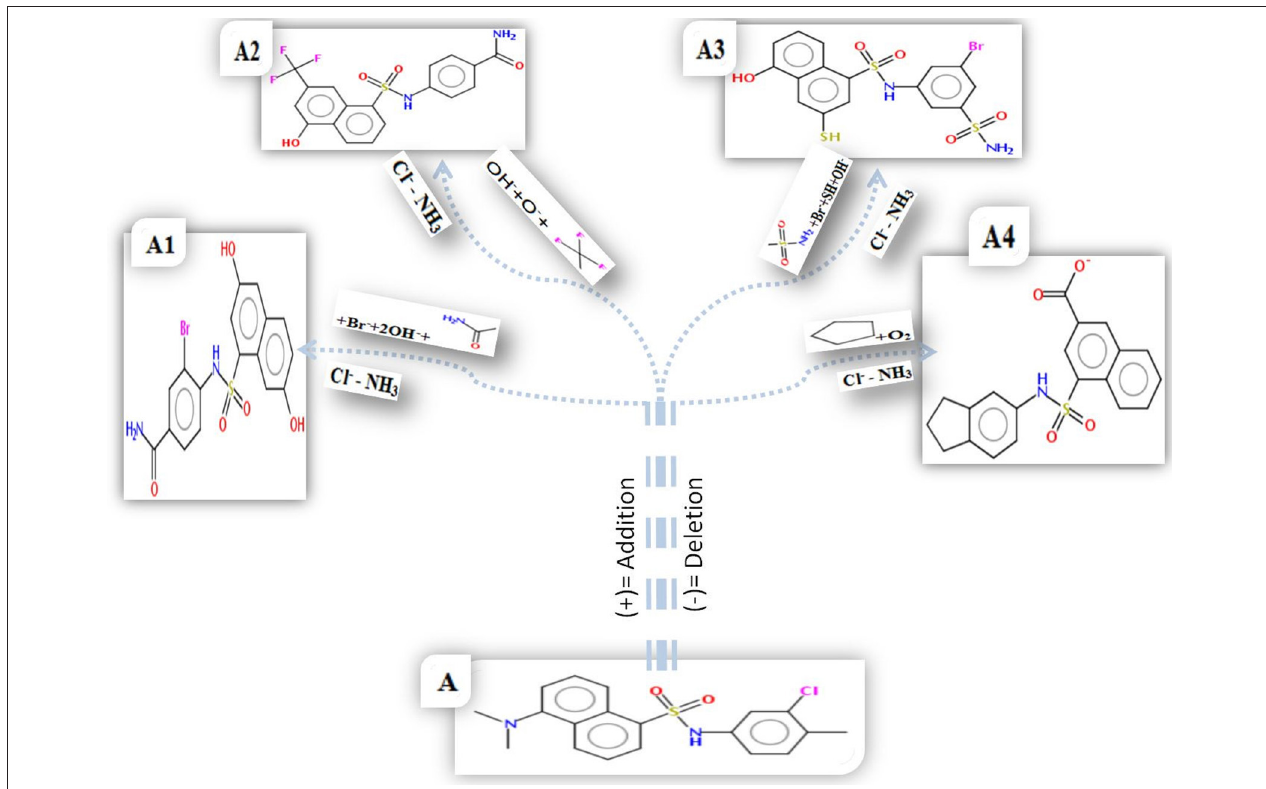
FIGURE 7 | 2D structure of parent compound AP30451 and design molecules. (A) Parent compound AP30451. Here, Cl − and NH 3 were deleted from the original compounds to generate the novel compounds as WNV inhibitors. (A1) Br − and 2OH − were added in designed molecule-1. (A2) OH − , O − and CF 3 added in design molecule-2. (A3) Br − , OH − , SH etc. were added in designed molecule-3. (A4) O 2 and a ring structure added in designed molecule-4.